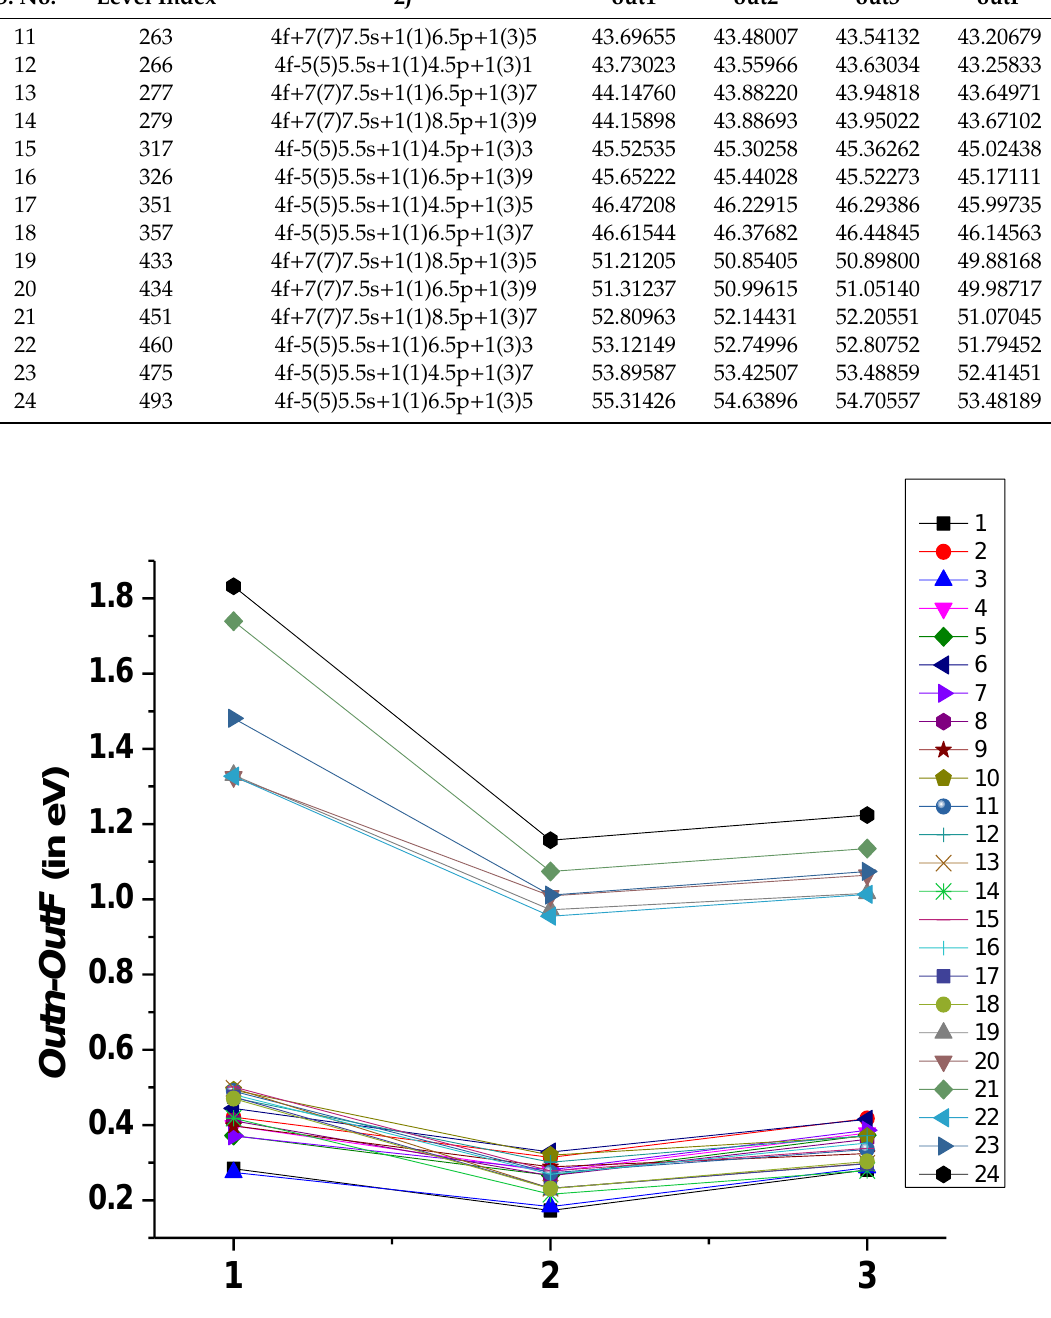
Figure 4. Differences of energy intervals relative to the lowest level (with index 1) for each output OUTn (n = 1, 2, 3) from the final calculation for the 4f135s5p configuration. Table 10 presents the energy levels (in Rydberg) for the lowest 500 levels calculated with FAC for Pm-like W. As can be seen from this table, we report results for many new levels that are not listed in the NIST tables [9]. The format of Table 10 is the same as in Table 1. Since 85 levels out of 500 of Table 8 have the same ‘2 J ’ label as some other levels, we report the eigenvector compositions and